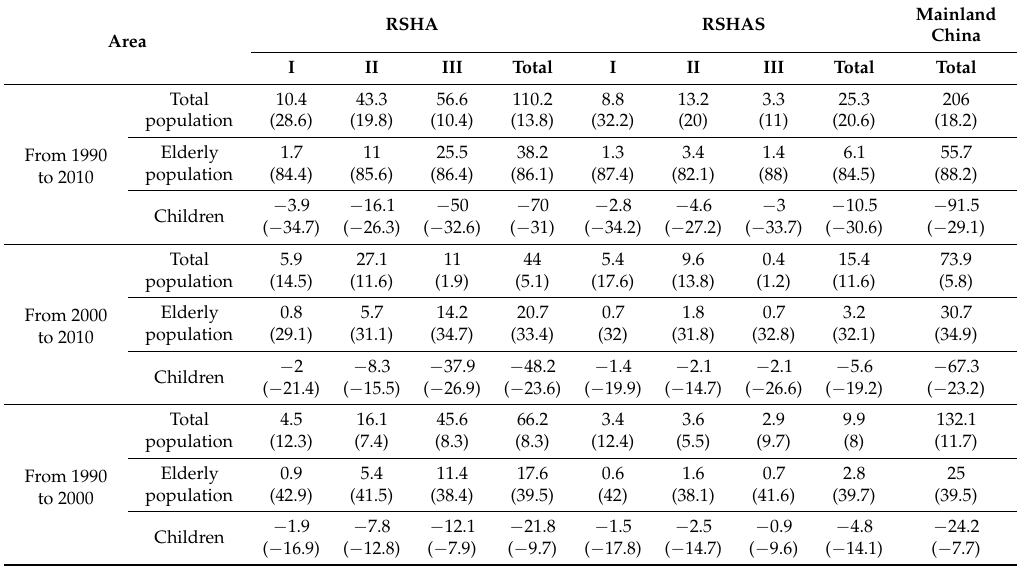
Table 3. The change of population exposure, unit: